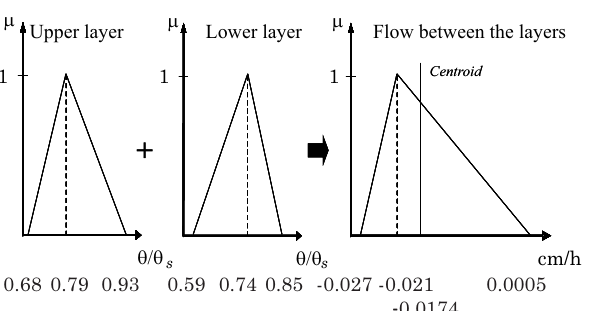
Figure 4. A fuzzy rule adopted for the vertical flow between two soil layers.